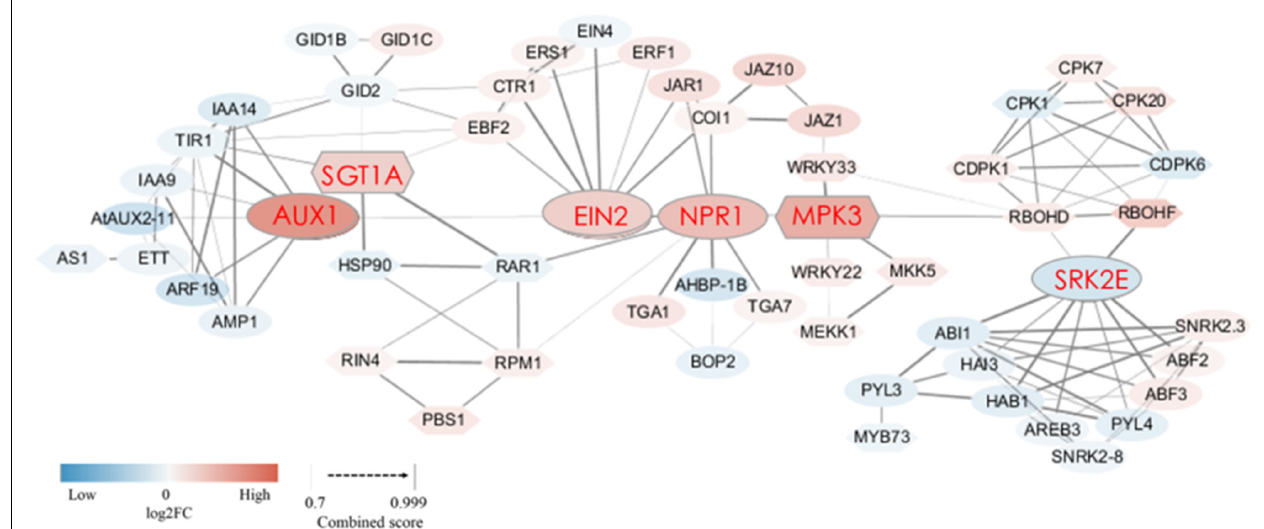
FIGURE 6 | Protein interaction network of DEGs encoding 58 proteins related to plant-pathogen interaction and plant hormone signal transduction in SB_vs_DB. The ovals represent the proteins related to plant hormone signal transduction, and the hexagons represent proteins related to plant-pathogen interaction. The thickness of the connecting line represents the confidence of the predicted protein interaction. The color in each node represents the continuous log2FC. Blue and red colors represent down-regulation and up-regulation, respectively. Detailed annotation information regarding DEGs related to plant-pathogen interaction and plant hormone signal transduction was shown in Supplementary Table 5